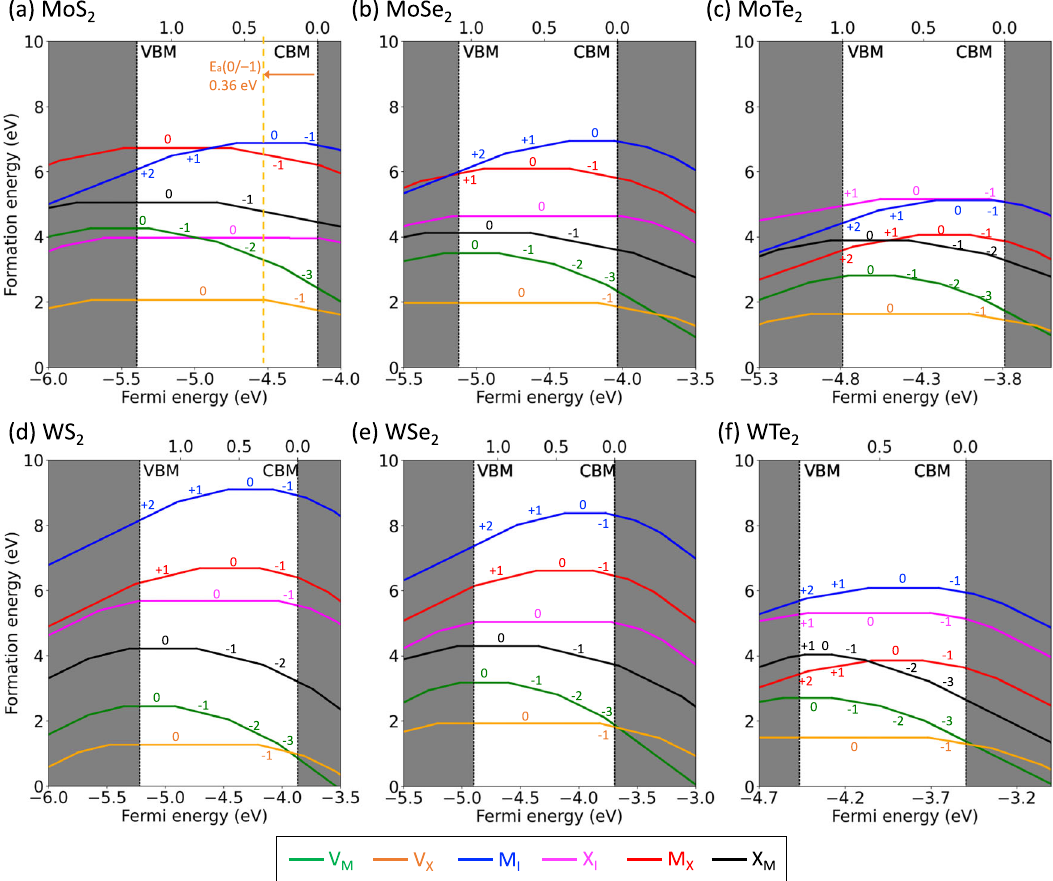
Fig. 1 Defect formation energies of point defects in bulk TMDs. The defect formation energies calculated at the chalcogen-rich condition as a function of Fermi energy in bulk ( a ) MoS 2 , ( b ) MoSe 2 , ( c ) MoTe 2 , ( d ) WS 2 , ( e ) WSe 2 , and ( f ) WTe 2